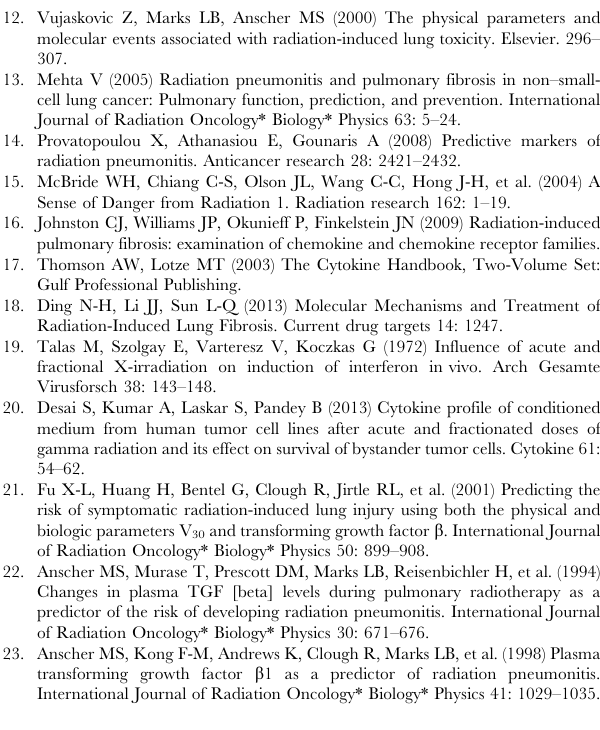
Table S1 Individual patient characteristics and respi- ratory toxicity. Table S2 Two-way ANOVA testing the effect of treat- ment (chemoRT vs RT alone) and sample time point. All cytokines in which the plasma concentrations varied significantly dependent upon the treatment group are highlighted in bold and by an asterisk (*). The Interaction between treatment group and sample time point is tested, and residual errors are